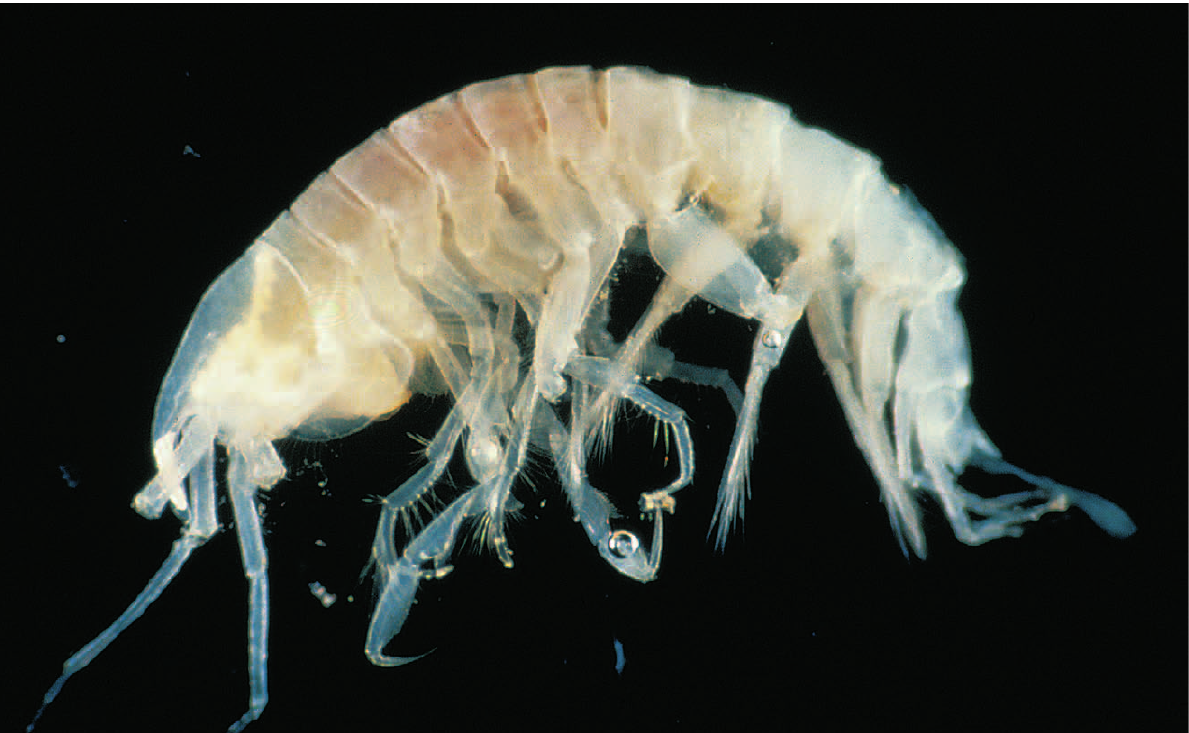
Fig. 1. — Bathymedon longirostris sp. nov., adult (cid:2) . Fresh specimen retaining eye and body